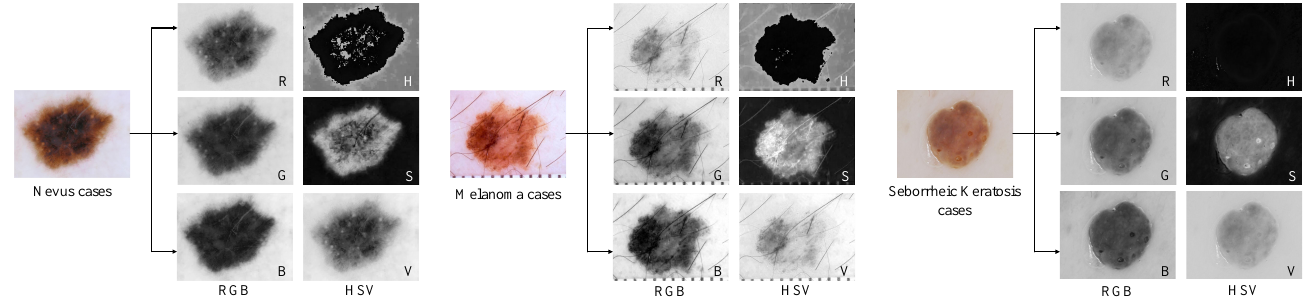
Figure 7. Visual description of the input dermoscopy image in different color